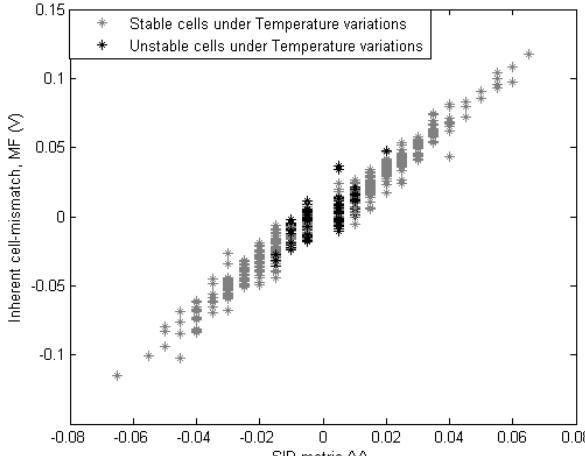
Figure 13. The relationship between the proposed metrics demonstrating stable and unstable cells under temperature changes.